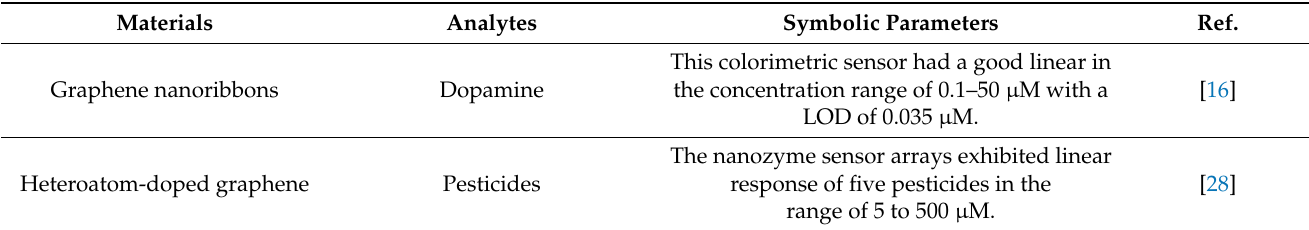
Table 1. Colorimetric sensors based on graphene and its derivatives. Analytes Ref.